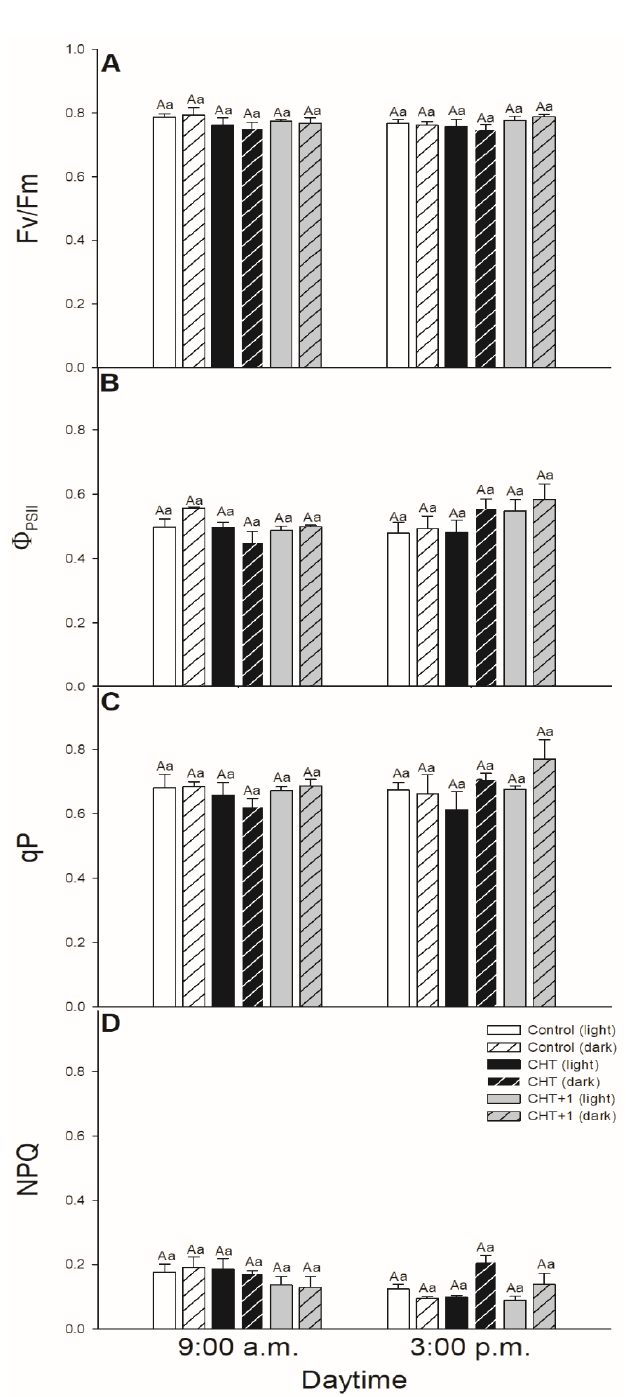
Figure 6. Changes in the chlorophyll a fluorescence parameters [Fv / Fm ( A ), Φ PSII ( B ), qP ( C ), NPQ ( D )] of stomata on the abaxial epidermal strips of intact tomato plants treated foliar with 100 µ g mL –1 chitosan (CHT) dissolved in the experimental bu ff er (1 mM AA, 10 mM MES / TRIS, 10 mM KCl, 0.1 mM CaCl 2 , pH 6.15) in the morning: 08:00 hrs, keeping under light (normal columns) or in continuous darkness (stripped columns)]. Measurements were disposed at constant times after treatments (09:00 and 15:00 hrs). Means ± SE, n = 3. Means were analyzed by two-way ANOVA, significant di ff erences among the data were analyzed by Holm-Sidak test. Mean values significantly di ff erent at P < 0.05 were signed with di ff erent letters, upper case letters indicate the e ff ects of the treatment at the same daytime, and lower case letters indicate the e ff ects of the daytime under the same treatment. (Control: treatment with 1 mM Acetic acid bu ff er (AA); CHT: treatment with 100 µ g mL –1 chitosan in experimental bu ff er containing AA; CHT + 1: untreated distal leaf level from the CHT-treated